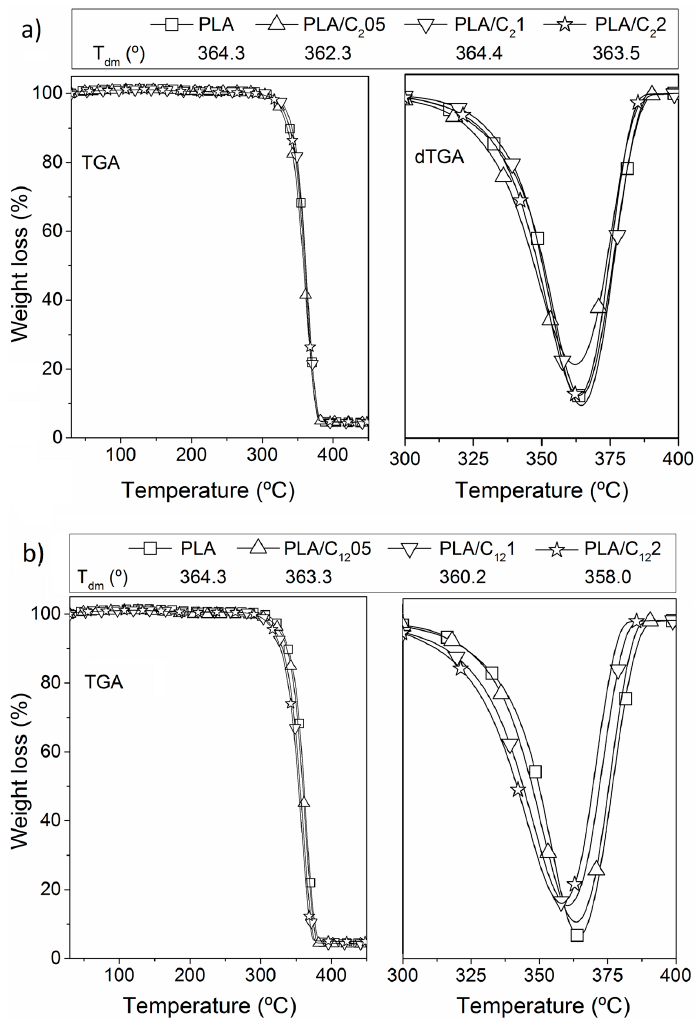
Figure 7. Themogravimetric analysis of: PLA/C 2 nanocomposite ( a ); and PLA/C 12 nanocomposite ( b ).